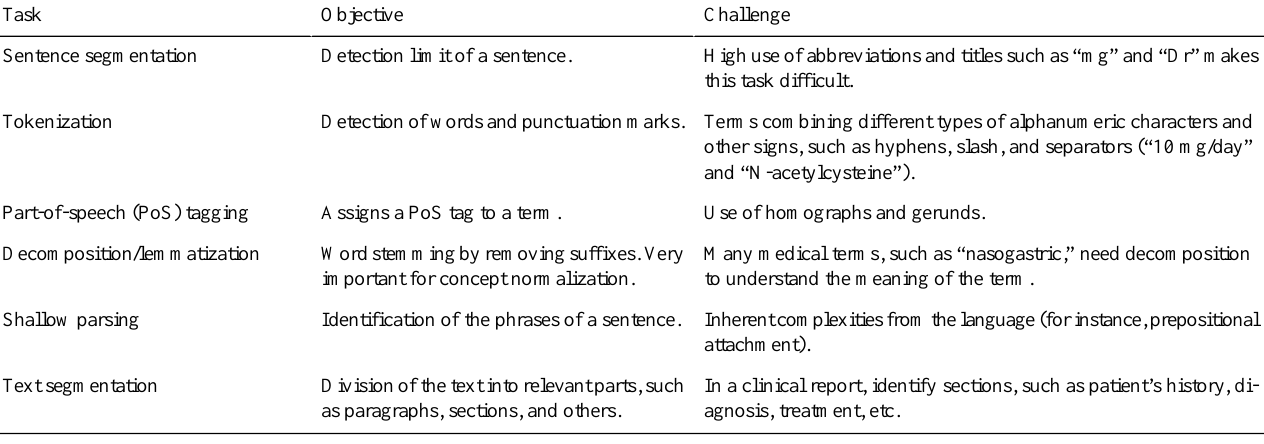
Table 2. Natural language processing high-level tasks.